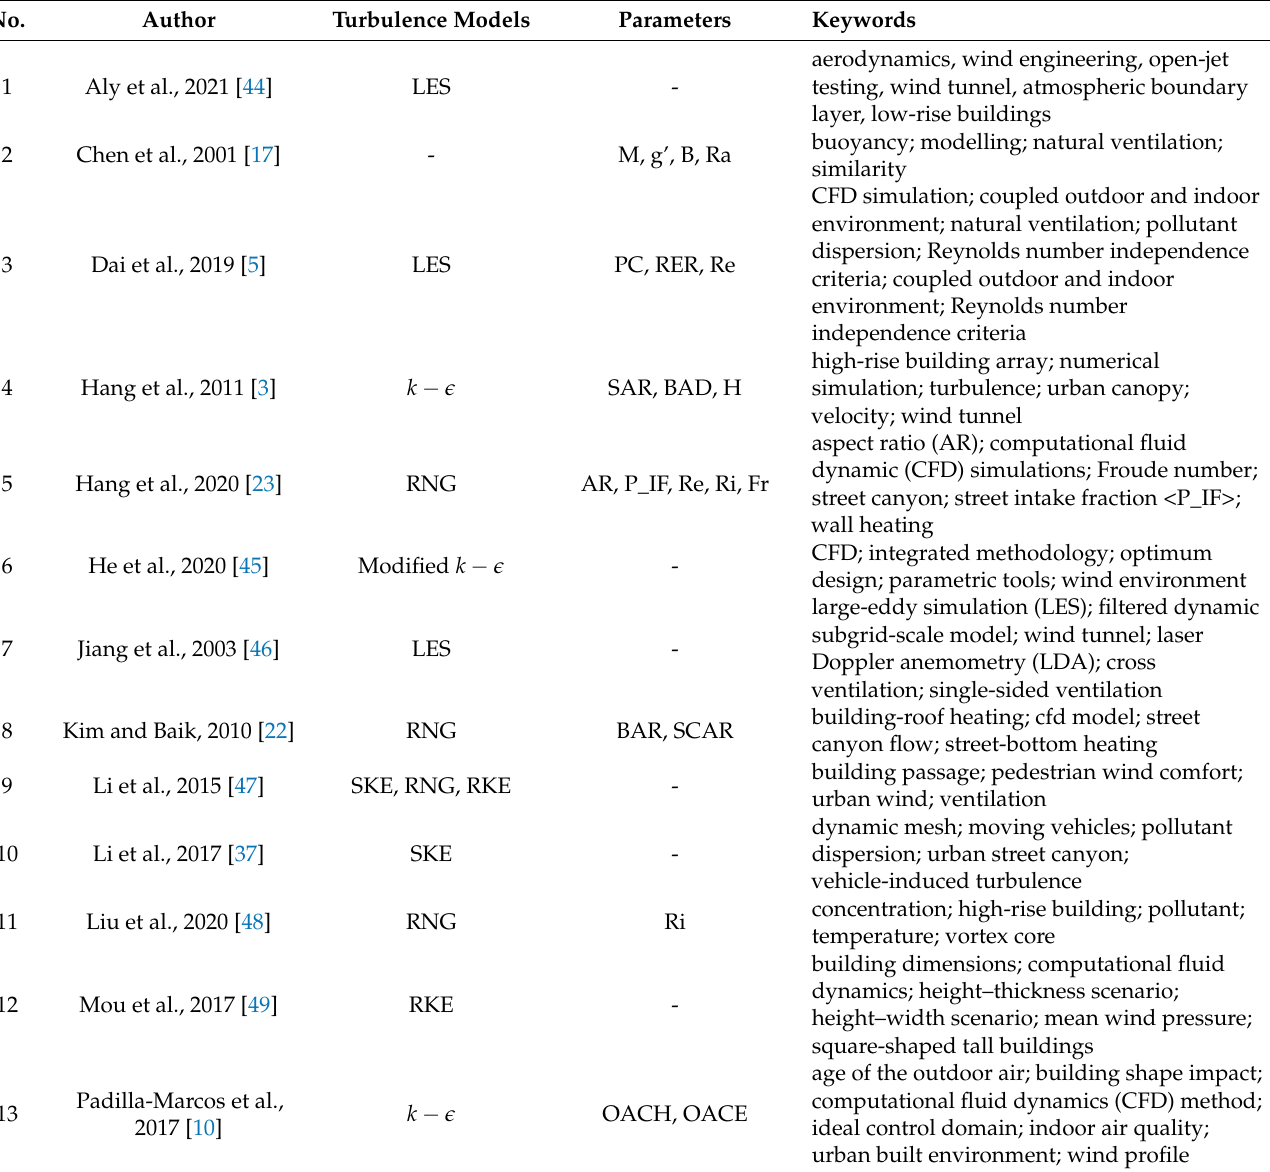
Table 2. Overview of studies of fictitious urban areas with validation comparison with experimental or numerical data: adopted turbulence models and parameters, and listed